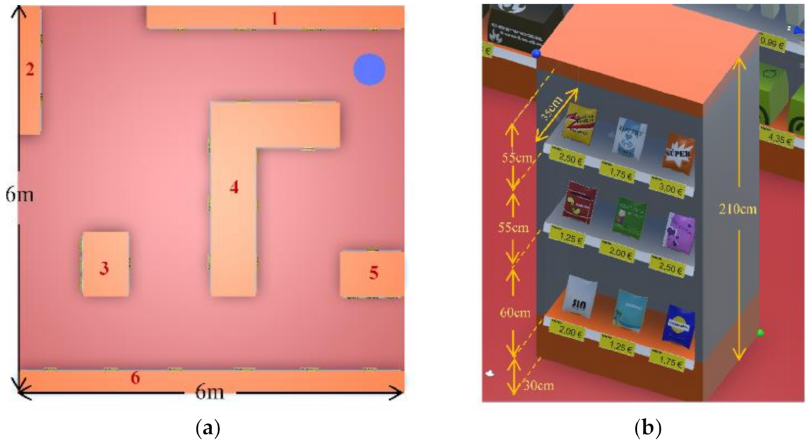
Figure 1. ( a ) The positions of the 6 orange shelves and the blue circle on the 6 × 6 m 2 floor plan of the virtual store. ( b ) The dimensions of the shelves in the virtual